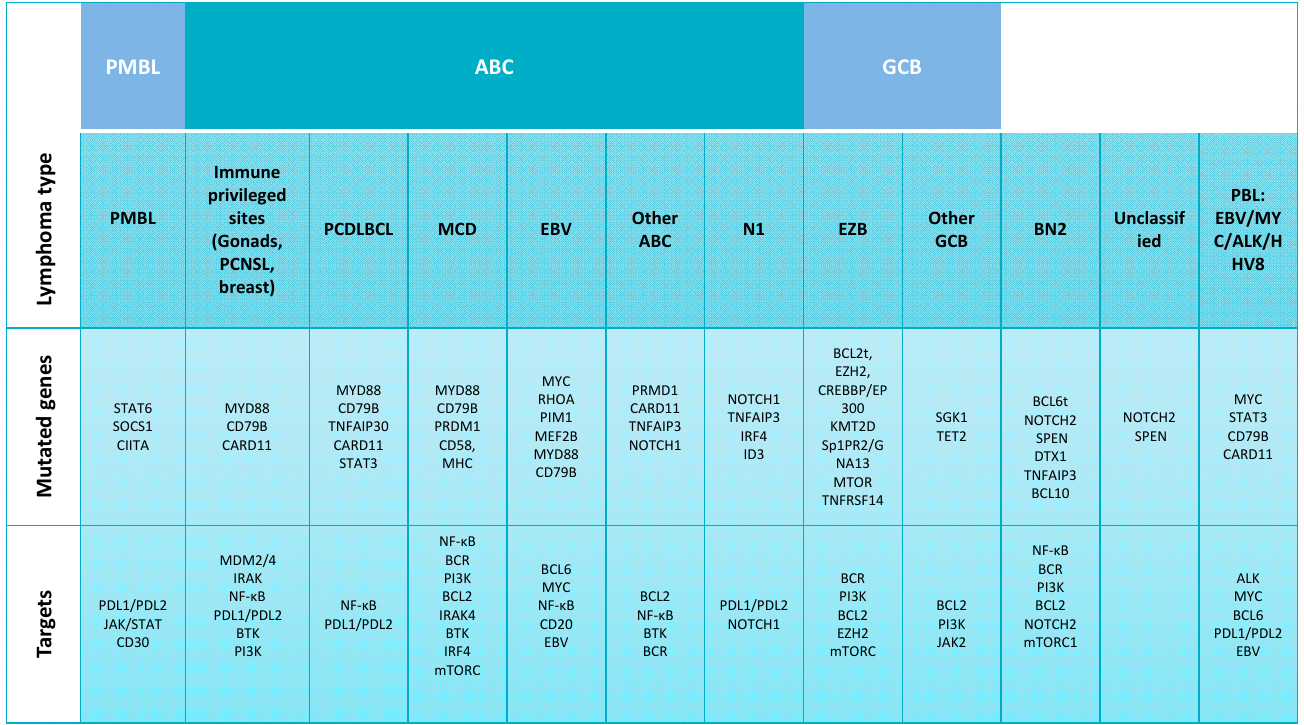
Figure 1. Diffuse large B-cell lymphoma classification and molecular alterations. Subgroups of diffuse large B-cell lymphoma (DLBCL), including its molecular subgroups activated B cell-like (ABC) DLBCL and germinal center B cell-like (GCB) DLBCL defined by gene expression and genetic analysis. Each column represents one subtype. Abbreviations: DLBCL, diffuse large B-cell lymphoma; PTL, primary testicular diffuse large B-cell lymphoma; PCNSL, primary DLBCL of the central nervous system; PMBL, mediastinal large B-cell lymphoma; PCDLBCL, primary cutaneous diffuse large B-cell lymphoma leg-type; MCD, cooccurrence of MYD88 L265P and CD79B mutations; EBV, Epstein–Barr virus; N1, NOTCH1 mutations; EZB, EZH2 mutations and BCL2 translocations; BN2, BCL6 fusions and NOTCH2 mutations; PBL, plasmablastic lymphoma; BTK, Bruton’s tyrosine kinase inhibitors; BCR, B-cell receptors; PI3K, phosphoinositide 3-kinase; BCL6t, BCL6